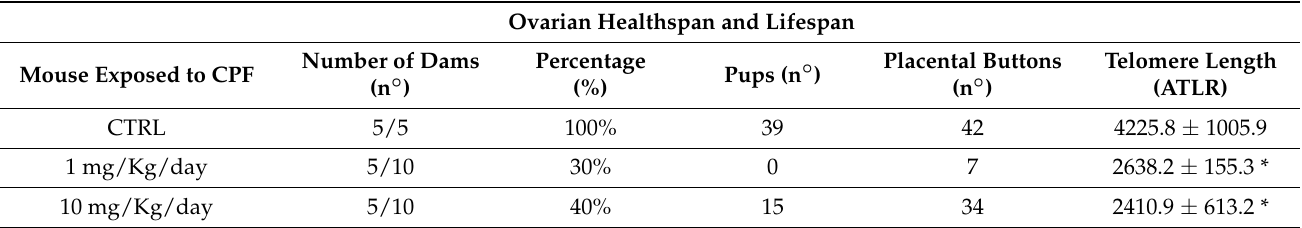
Table 2. Ovary healthspan and lifespan alterations in mice exposed to